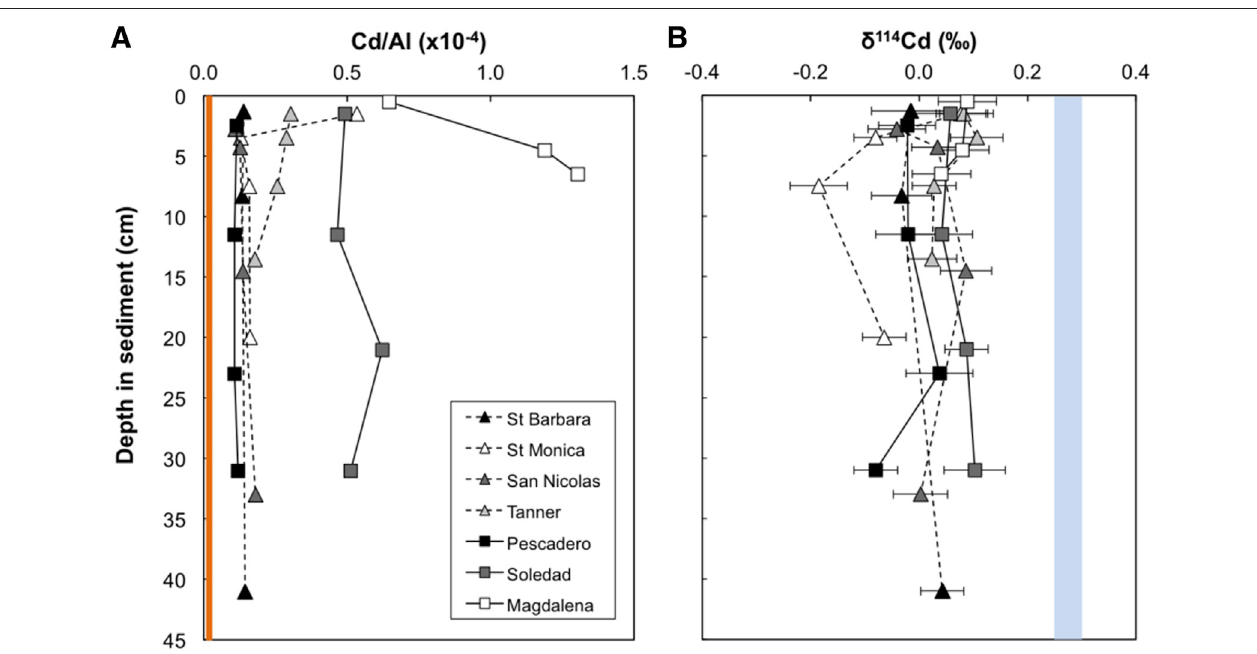
FIGURE 2 | Downcore variability in bulk Cd/Al ( A) and δ 114 Cd ( B) for seven sites from the two continental margin locations (California Borderland Basins — dashed lines, triangles; Mexican Margin — solid lines, squares). The orange bar represents the Cd/Al ratio of the upper continental crust (Rudnick and Gao, 2003). The blue bar represents average deep seawater δ 114 Cd (+0.25 – 0.3 ‰— see text for references). Error bars are the external 2 SD on sample replicates or of a secondary standard (BAM, ± 0.05 ‰ ), or the internal 2 σ on an individual Cd isotope ratio measurement, whichever is